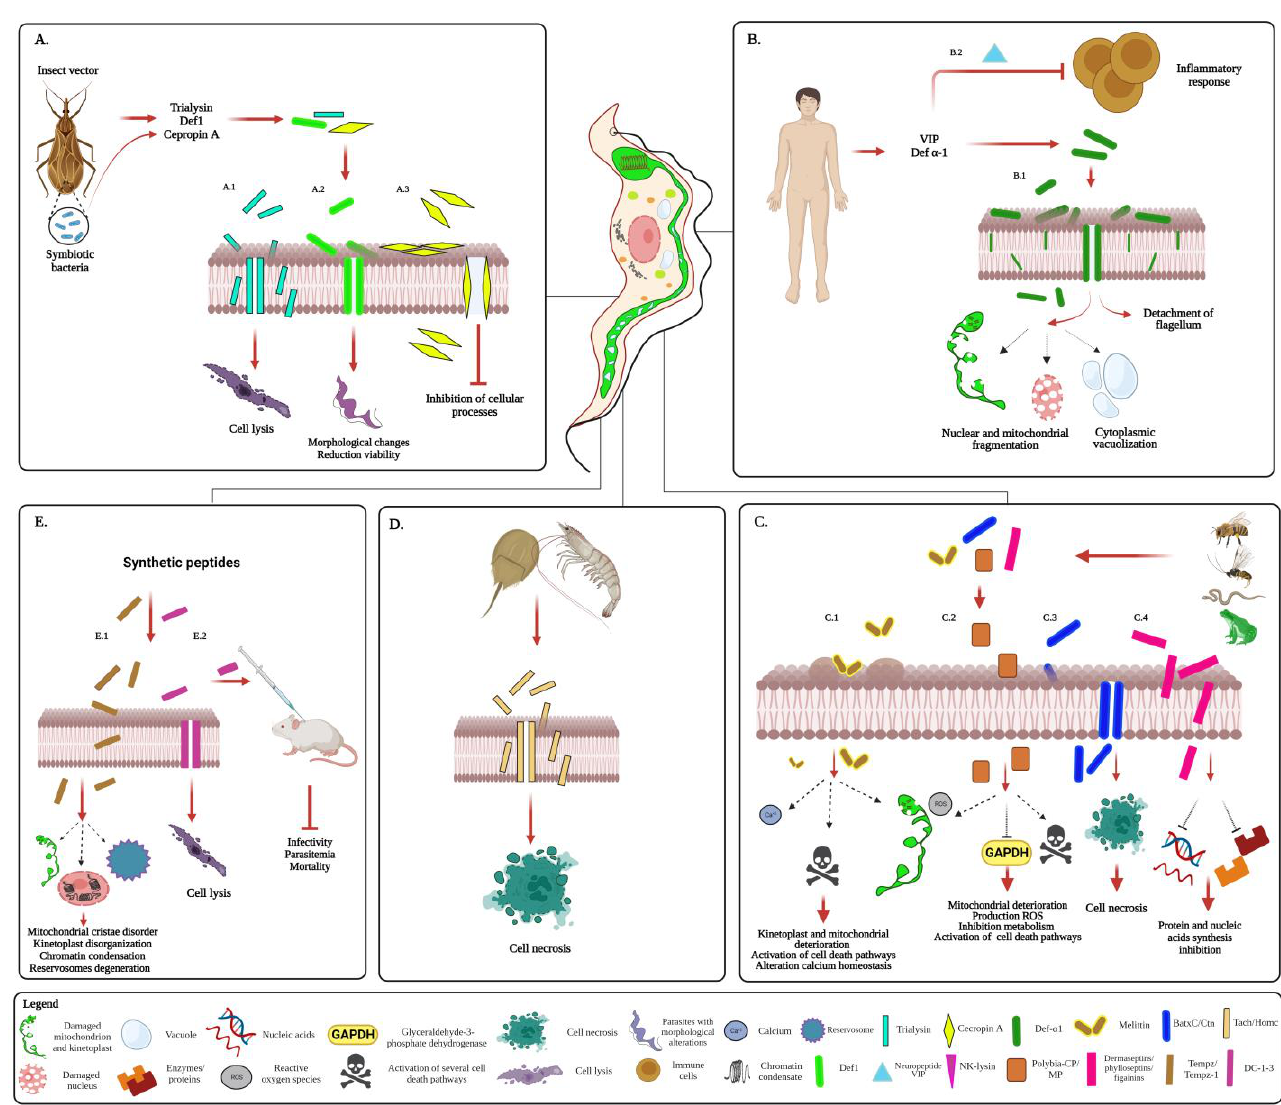
Figure 4. Mechanisms of action of antimicrobial peptides (AMPs) against T. cruzi . ( A ). AMPs derived from the insect vector. These AMPs carry out their activities by disturbing the plasma membrane and forming pores in it. ( A.1 ). Trialysin induces cell lysis. ( A.2 ). Def1.3 promotes morphological alterations, reduced viability, and inhibits growth of the parasites. ( A.3 ). Cecropin A perforates the plasma membrane, causing cell lysis. ( B ). AMPs derived from the human host. ( B.1 ). Def-α-1 exerts its trypanocidal effect through membrane pore formation, cytoplasmic vacuolization, and the in- duction of nuclear and mitochondrial DNA fragmentation, and detachment and release of the fla- gellum, leading to parasite destruction. Preincubation of parasites with this peptide inhibits their infective ability and causes reduction of the parasitemia. ( B.2 ). The neuropeptide VIP modulates the inflammatory response to T. cruzi , reducing cardiac damage. ( C ). AMPs derived from other natural sources (insects, reptiles, and amphibians). ( C.1 ) Melittin induces structural changes (including dis- ruption of the plasma membrane, structural changes in the mitochondrion, kinetoplast disorgani- zation, and structural alterations of the flagellum), alteration of Ca 2+ homeostasis, and activation of different cell death pathways in the parasite. ( C.2 ). Polybia-CP and MP carry out their trypanocidal effect through the promotion of ROS, mitochondrial dysfunction and apoptosis-like cell death. Ad- ditionally, MP can inhibit the glycolytic enzyme GAPDH. ( C.3 ). BatxC and Ctn induce the formation of pores in the plasma membrane, promoting the formation of ROS, loss of the mitochondrial mem- brane potential, and cell death by necrosis. ( C.4 ). Peptides dermaseptins 1/4 and phylloseptins 7/8 have trypanocidal activity through disruption of the plasma membrane and effect on several intra- cellular targets (such as protein and nucleic acids synthesis). ( D ). AMPs derived from aquatic or- ganisms. Peptides isolated from marine organisms (Tach and fragments from hemocyanin) have